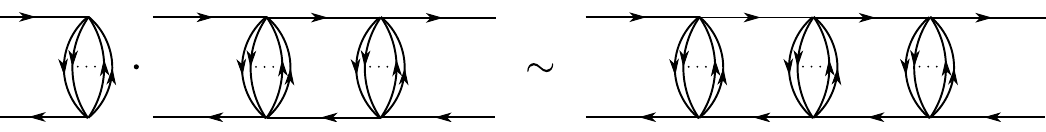
Figure 2 . Kernel adds a rung to the ladder